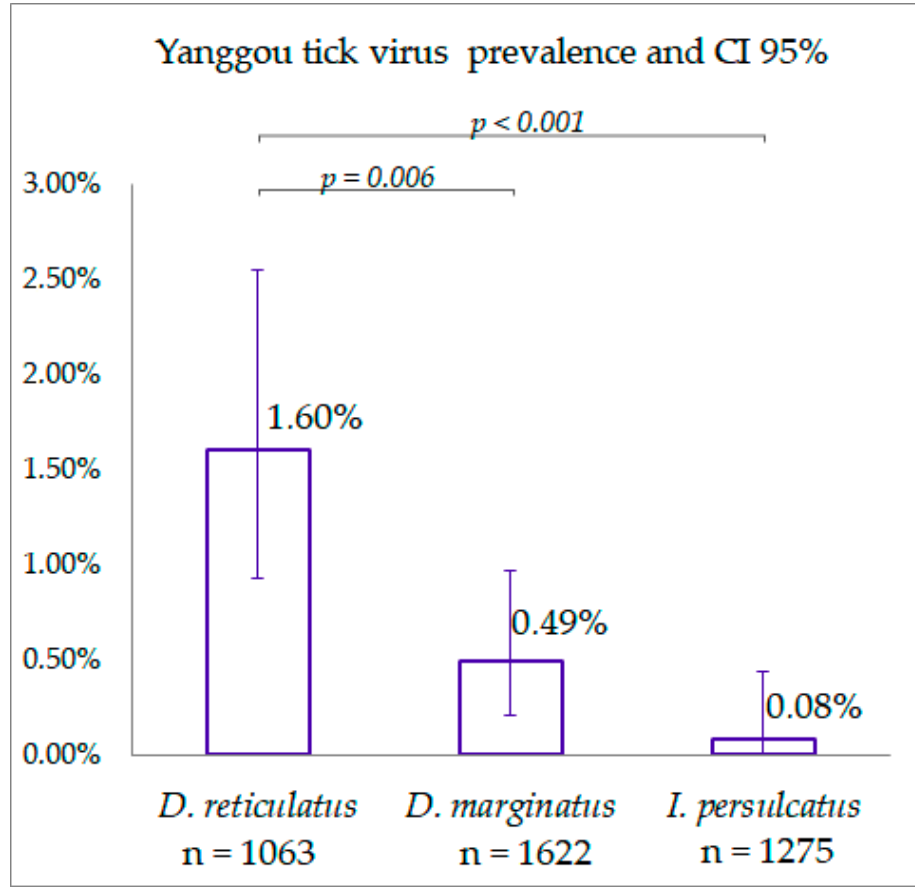
Figure 5. Mean Yanggou tick virus prevalence in different tick species calculated in all samples of the Chelyabinsk region. Error bars represent the 95% confidence intervals. The p-values of Fisher’s exact test are shown for species with significant differences in